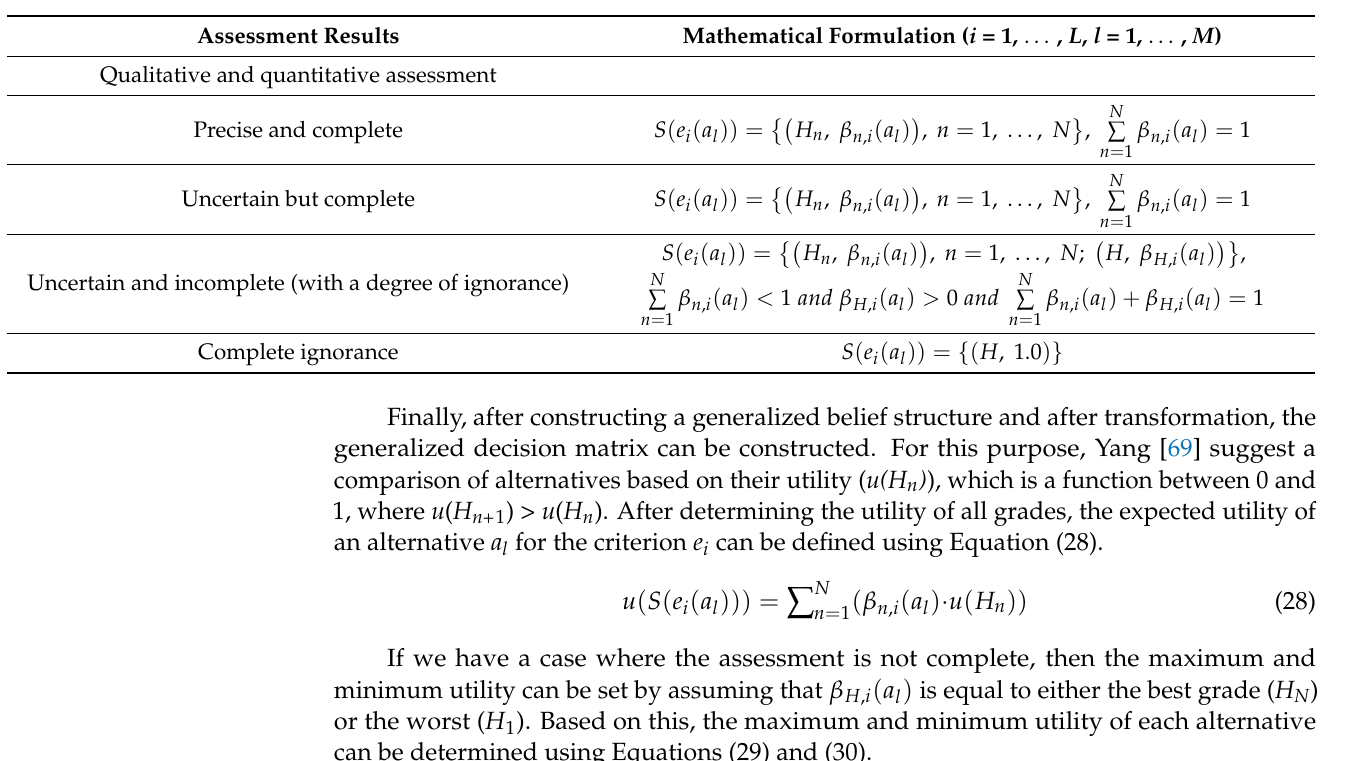
Table 5. Generalized belief structures after rule-based transformation